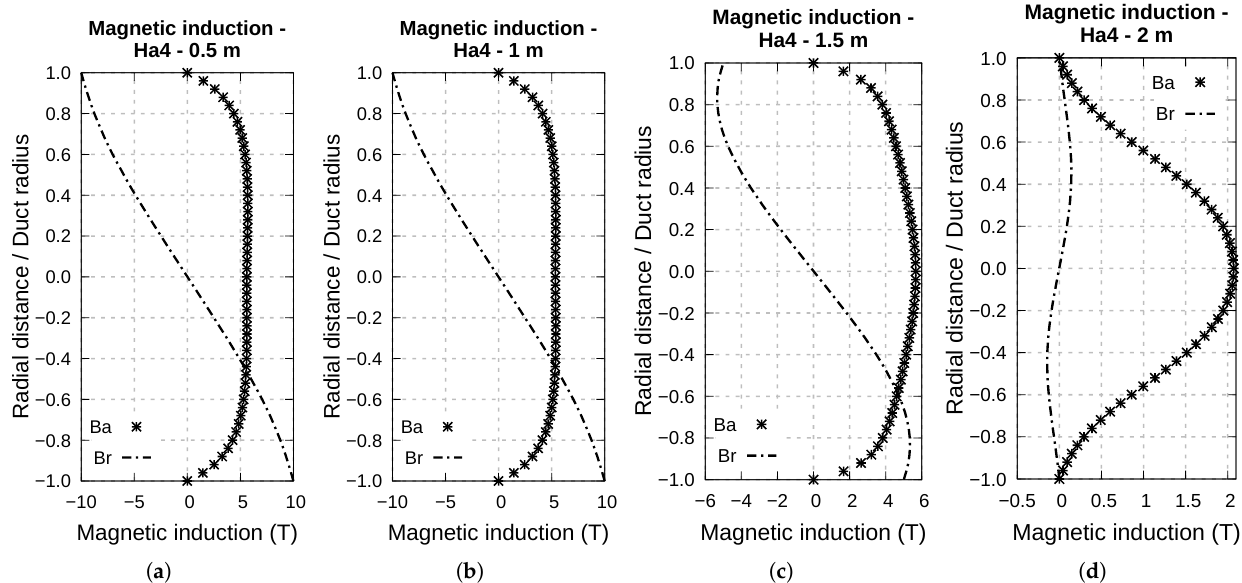
Figure 13. Behavior of axial and radial components of magnetic induction at the positions ( a ) 0.5 m, ( b ) 1.0 m, ( c ) 1.5 m and ( d ) 2.0 m from the duct inlet. Hartmann number is Ha 4 and magnets are in the repulsive